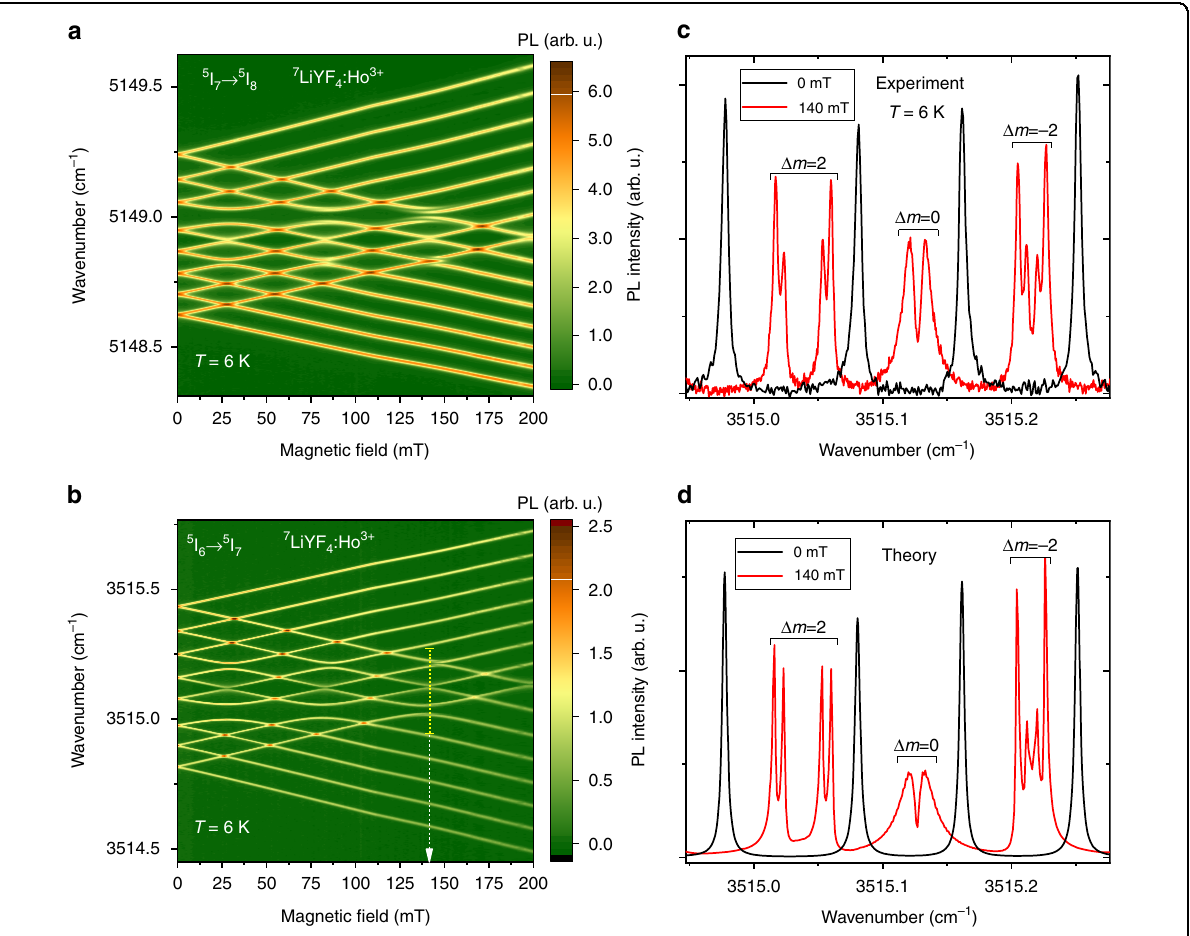
Fig. 6 Anticrossings of the hyper fi ne levels in the luminescence spectra of 7 LiYF 4 :Ho 3 + in a magnetic fi eld B || c . a , b Luminescence intensity maps in the magnetic- fi eld – wavenumber scale for the a 5 I 7 Г 34 (5155.75) → 5 I 8 Г 2 (6.85) and b 5 I 6 Г 2 (8670.9) → 5 I 7 Г 34 (5155.75) transitions in 7 LiYF 3 + (0.1 at. %) at 6 K. Anticrossings of the hyper fi ne levels are observed. c Experimental and d simulated fragment of the spectrum 4 :Ho corresponding to the 5 I 6 Г 2 (8670.9) → 5 I 7 Г 34 (5155.75) transition of 7 LiYF 4 :Ho 3 + (0.1 at. %) in a zero magnetic fi eld (in black) and in the fi eld of 140 mT (in red), indicated by an arrow in b